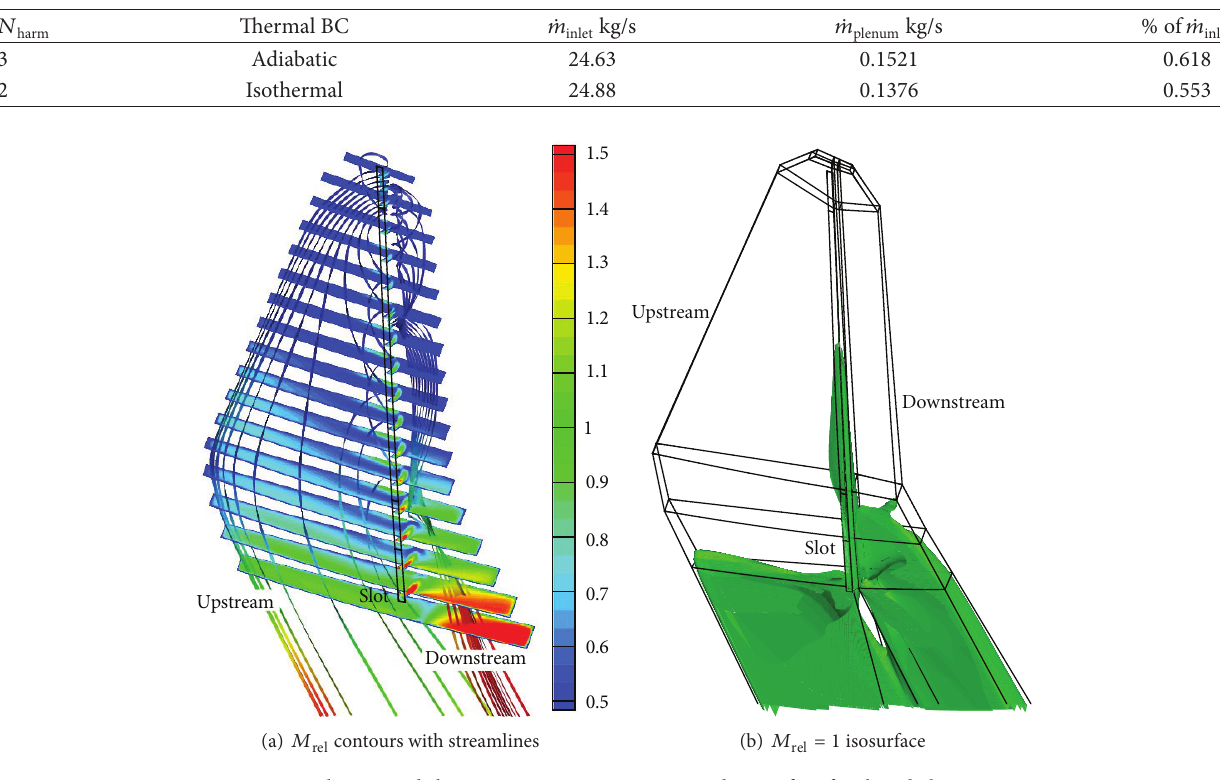
F 11: Plenum and slot time mean